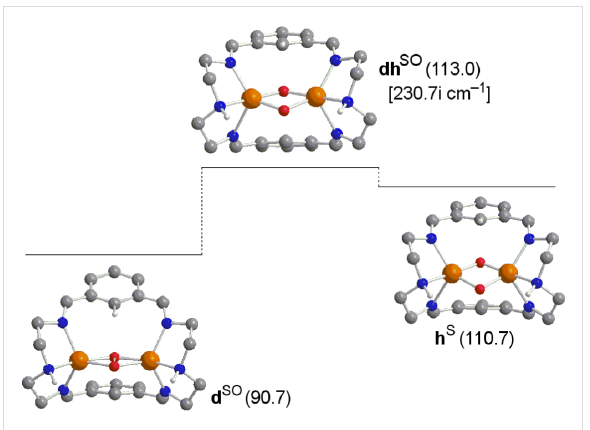
Figure 2: Computed structures of the potential equilibrium between the peroxo and bis- μ -oxo intermediates (some H atoms omitted for clarity). Gibbs energies relative to product g (in kcal·mol − 1 ) in solution are given in parentheses. Calculated imaginary frequencies for tran- sition structures are given in brackets. Superindexes SO (open-shell singlet) and S (closed-shell singlet) refer to the multiplicity of the ground